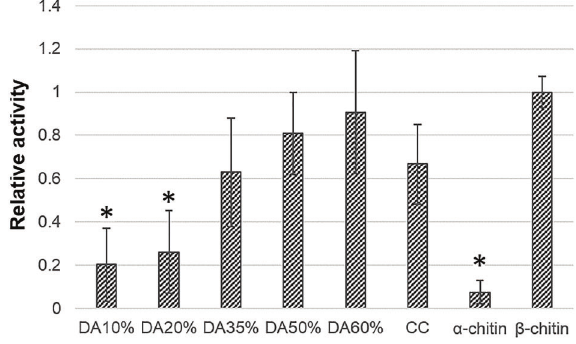
Figure 3. Substrate speci fi city of MetaChi18A. Activities relative to the highest activity (135 U/mg on b -chitin) measured through quanti fi cation of reducing ends in a reaction with 1 g/L substrate in sodium acetate buffer, pH 5, 1 ng/ m L of enzyme and incubation at pH 5 and 50°C for 1.5 h. DA: degree of acetylation of chitosan; CC: colloidal chitin. Data are reported as the average of 3 independent experiments with standard errors. *P o 0.05, compared to b -chitin activity ( t